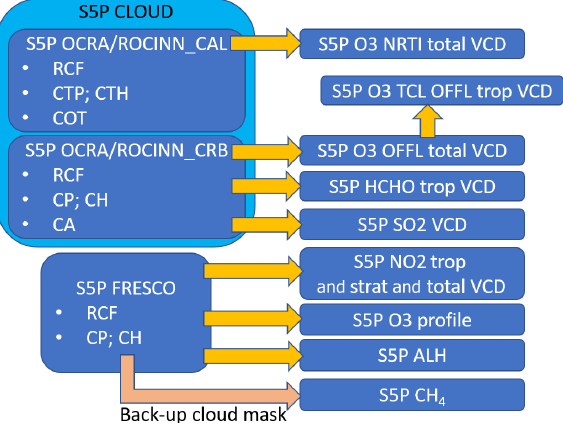
Figure 1. Flow chart indicating which S5P products use the cloud properties from S5P OCRA/ROCINN_CAL, S5P OCRA/ROCINN_CRB, and S5P FRESCO. Note that S5P OCRA/ROCINN_CAL and S5P OCRA/ROCINN_CRB cloud properties are contained in the same S5P CLOUD product files. At the time of submission of this work, the S5P O 3 profile is not yet operational. Note that regarding S5P CH 4 , NPP-VIIRS is used as the main cloud mask, while S5P FRESCO is merely a